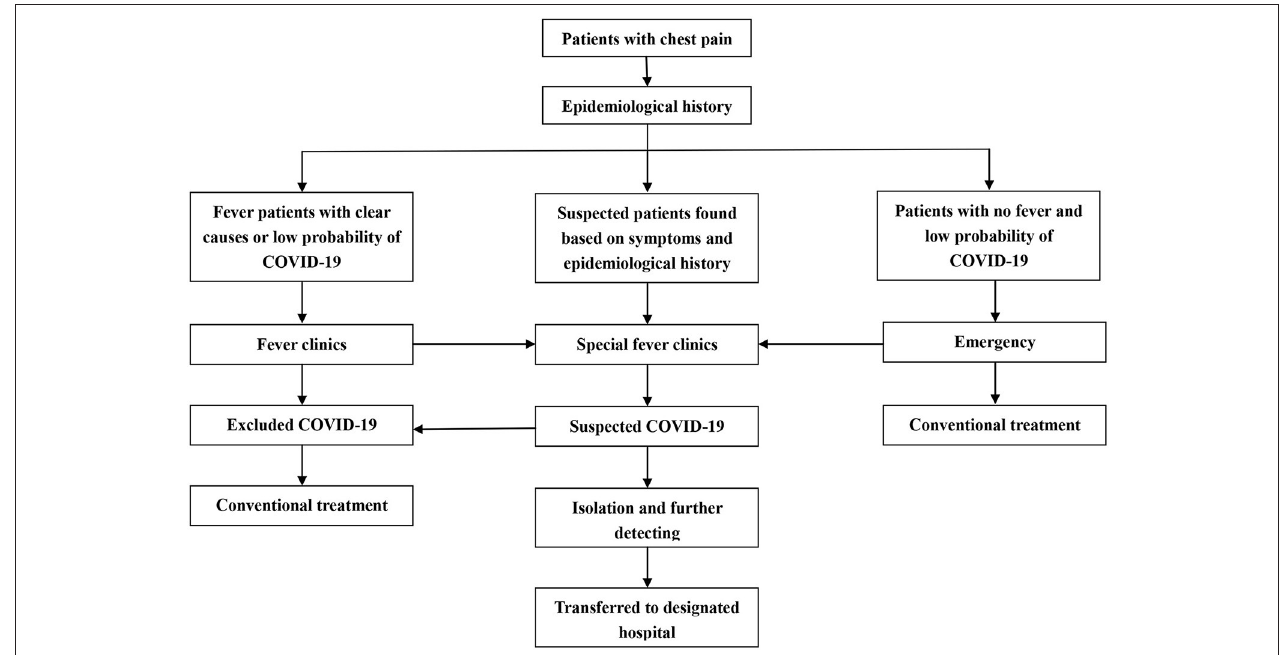
FIGURE 1 | Flowchart of emergency procedure.